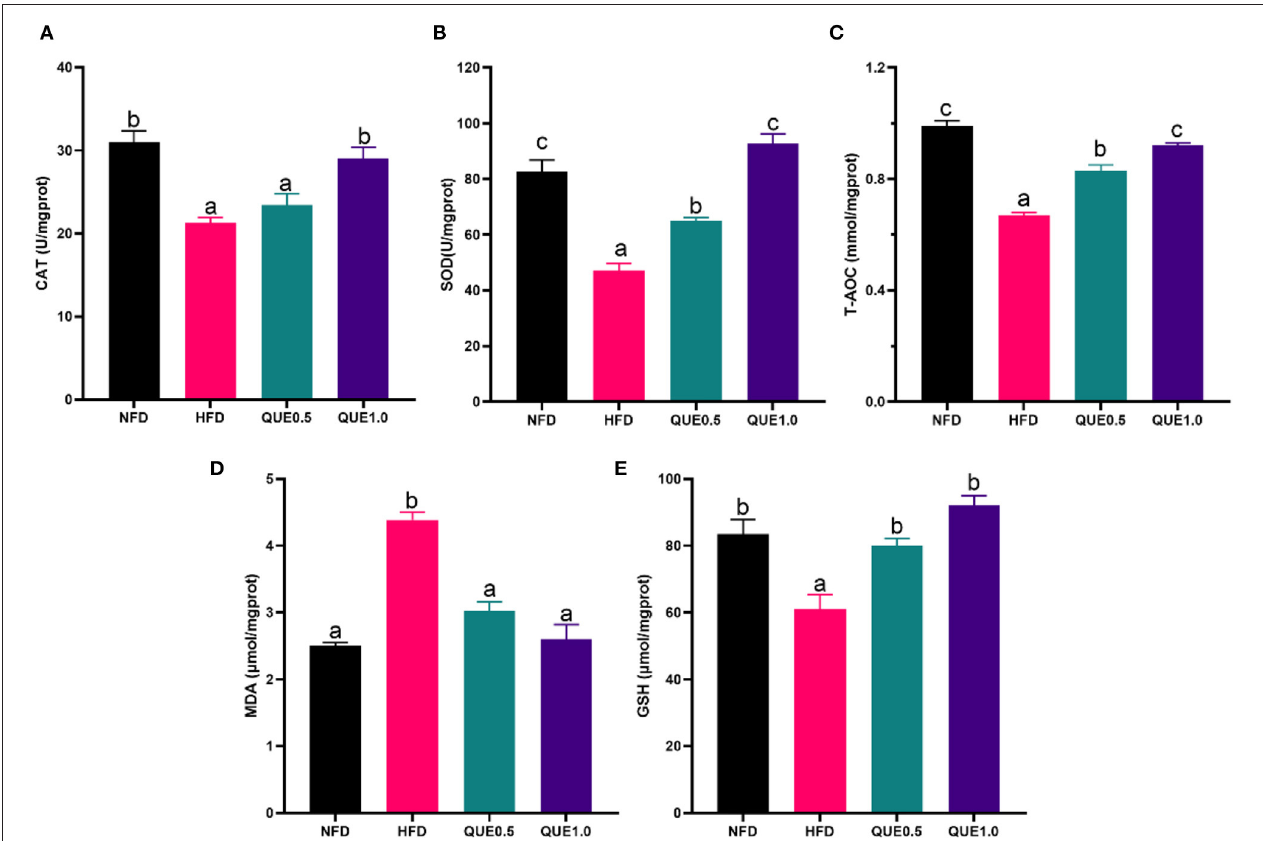
FIGURE 3 | Oxidative status in the liver of fish fed with experimental diets. (A) CAT activity. (B) SOD activity. (C) GSH content. (D) T-AOC. (E) MDA content. SOD, superoxide dismutase; GSH, glutathione; CAT, catalase; T-AOC, total antioxidant capacity; MDA, malondialdehyde. Different letters indicate a significant difference among groups ( P < 0.05).